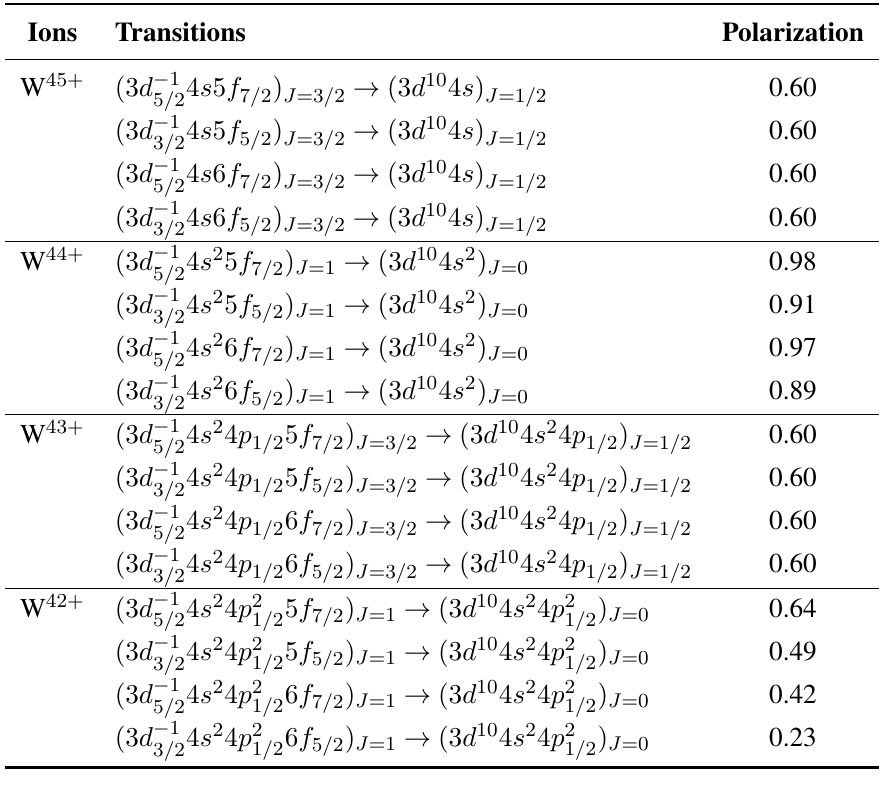
Table 3. The presently calculated degrees of linear polarization of X-ray emissions following resonant nf ( n = 5 , 6 ) electron captures of final W 45+ –W 42+ ions. Note that closed inner-subshells have been omitted from the initial and final levels of the radiative transitions for the sake of